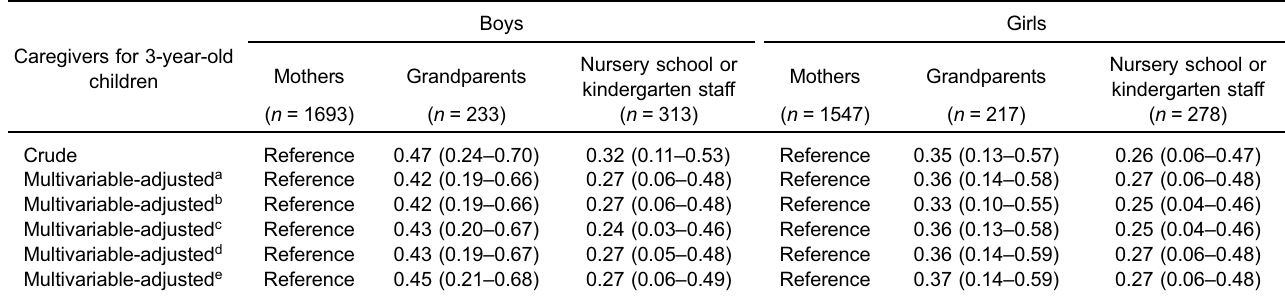
Table 4. Sex-speci fi c and multivariable-adjusted difference for BMI changes overtime according to caregivers by mixed effect